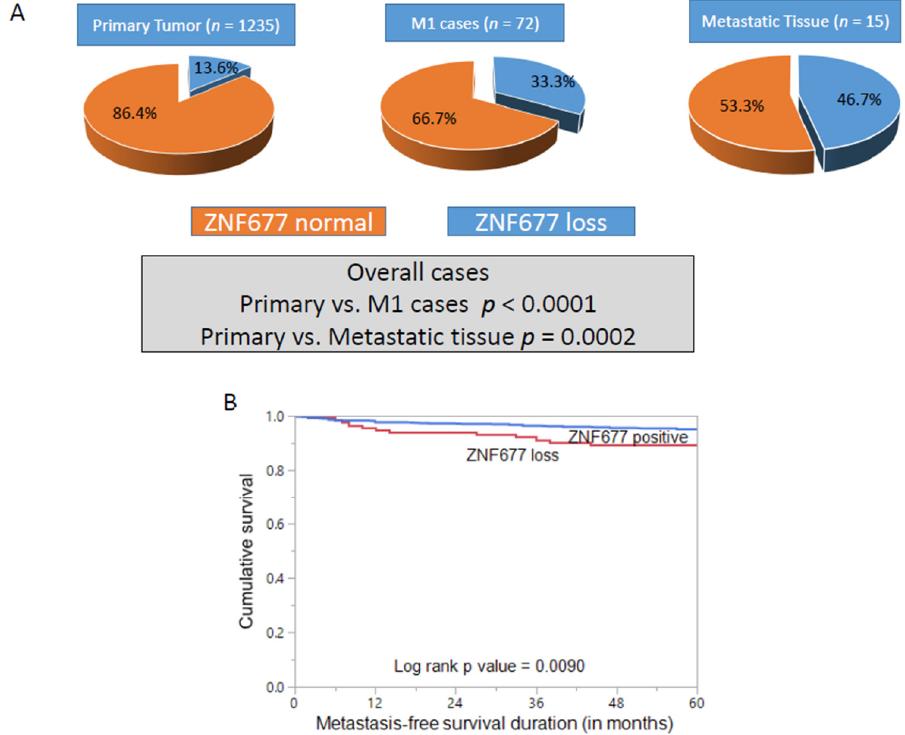
Figure 2. ( A ) Increasing proportion of ZNF677 loss in different PTC cohorts. ZNF677 loss was noted in 13.6% of primary tumors, 33.3% of M1 cases, and 46.7% of metastatic tissues. The difference in the frequency of ZNF677 loss between primary tumor and M1 cases as well as primary tumor and metastatic tissues was statistically significant ( p < 0.0001 and p = 0.0002, respectively). ( B ) Metastasis-free survival (MFS) analysis of ZNF677 protein expression in PTC. Kaplan–Meier survival plot showing statistically significant poor MFS in cases with ZNF677 loss compared to ZNF677-positive cases ( p =